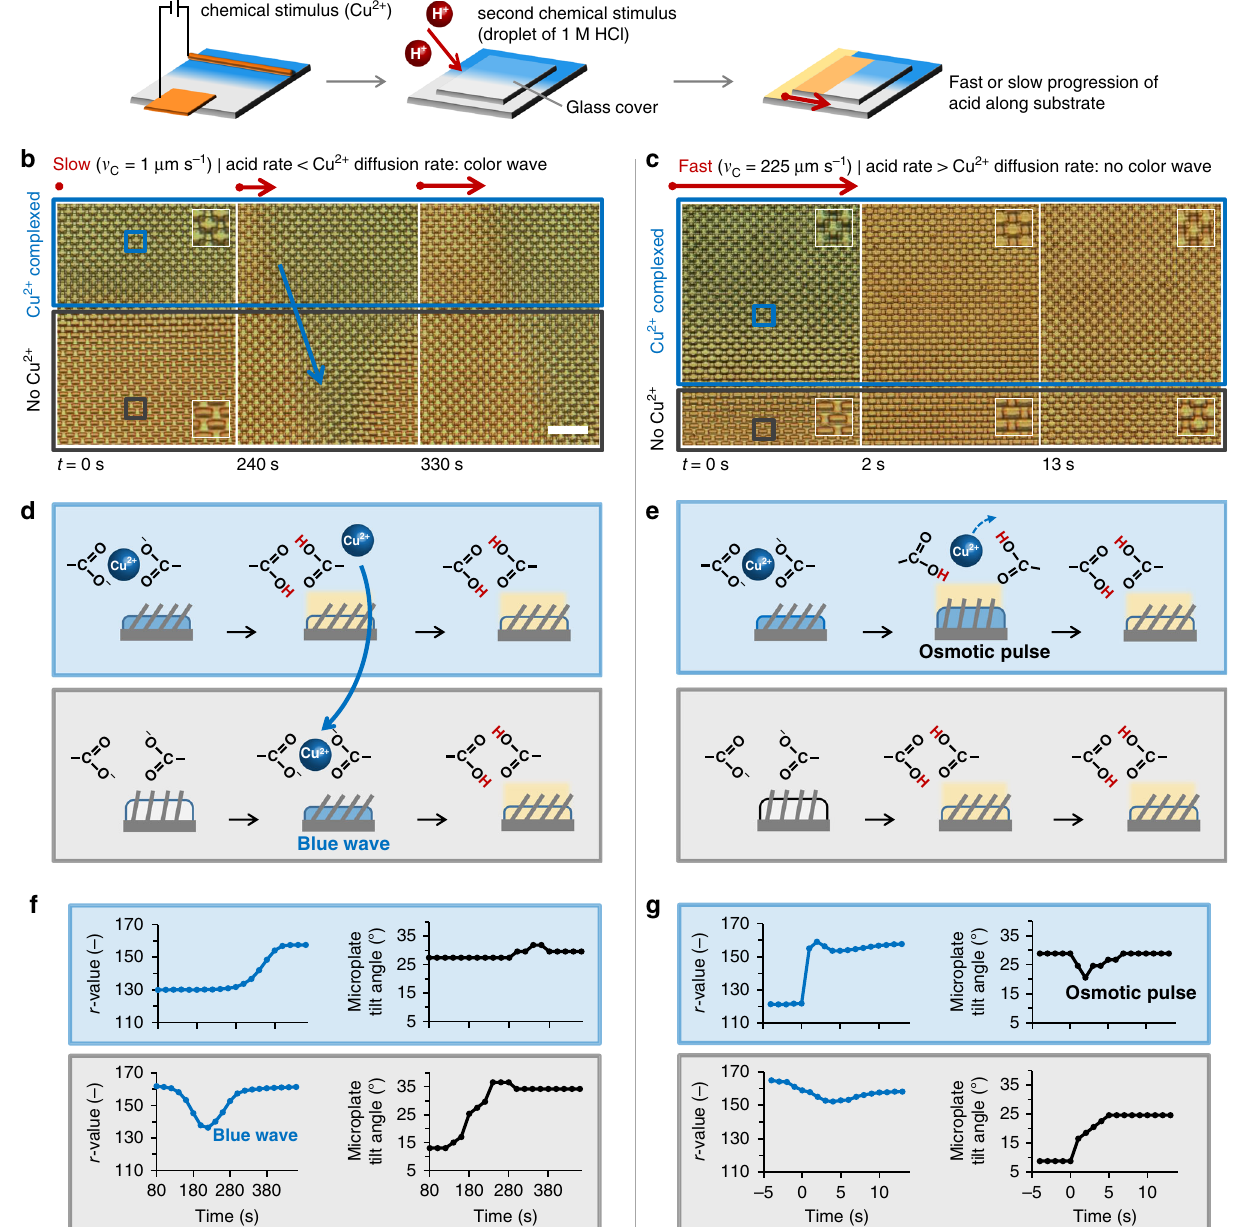
Fig. 5 Traveling color waves selectively reporting slowly progressing acid stimuli. a Schematic presentation showing the mechanism for the appearance of the travelling color waves: Cu 2 + is initially delivered electrochemically to one side of the substrate (blue region in diagram). A glass cover is then applied and the acid is added from the left and allowed to progress along the substrate. b Experimental demonstration of the slow acid progression: Cu 2 + is complexed in the region of the substrate where it was applied; slow progression of the acid (acid rate < Cu 2 + diffusion) allows Cu 2 + , released at the acid front in the Cu 2 + -complexing region (blue box), to migrate to the adjacent Cu 2 + -free region (blue arrow), generating a transient blue wave just ahead of the stimulus front (gray box). Scale bar: 50 µ m. c Fast progression of the acid from left to right (acid rate > Cu 2 + diffusion) induces a swelling/contraction wave in the Cu 2 + -complexing region (blue box) and a direct contraction of the hydrogel with no color wave in the region with no Cu 2 + (gray box). d , e Schematic representation of the subsequent stages for both regions in ( b ) and ( c ), respectively. f , g Time-dependent r value and microplate tilt angle, acquired at the blue and gray squares in ( b ) and ( c ), a region A, followed by diffusion of Cu 2 + through the super- To test this idea, we electrochemically delivered Cu 2 + across natant solution and recomplexation to the gel at a region B, can one half of a gel/microplate system, so that Cu 2 + is stored on one result in a transient band of Cu 2 + complexation. This must only side while the other remains copper-free (blue and white sides in happen when acid migration from A to B is slower than the Fig. 5a, respectively). Acid is then fl owed such that the front diffusion of Cu 2 + and its subsequent recomplexation at B: L x / v C progresses over both halves in parallel (Fig. 5a, yellow). This con fi guration potentially allows some of the released Cu 2 + at the > L x 2 / D (a) + τ Cu2 + , where L x ~ L ≈ 100 μ m is the distance between A and B, and D (a) is the diffusivity in the supernatant solution. front to diffuse to and recomplex on the copper-free side, subject